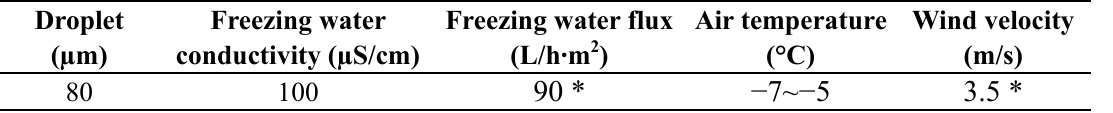
Table 3. Experimental ice deposit